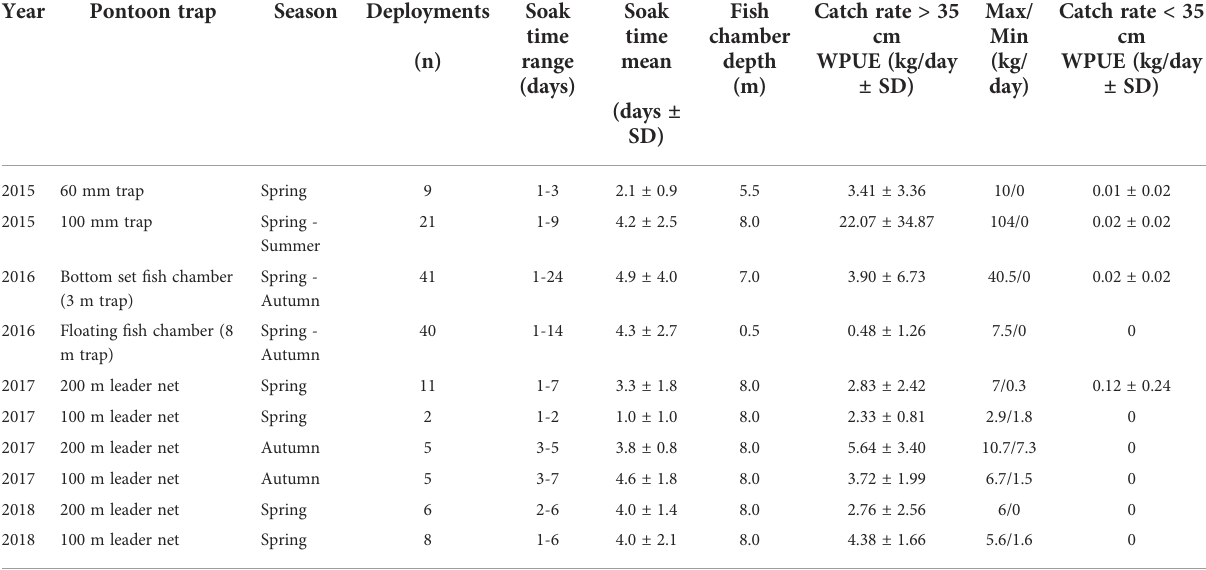
TABLE 2 Number of deployments for each trap in each trial, range and mean soak time, fi sh chamber depth (bottom set in all trials except 8 m trap in 2016) mean observed catch (WPUE) of commercial sized cod along with observed maximum and minimum catch and observed catch rates (WPUE) of undersized